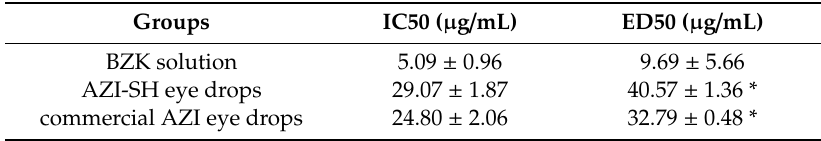
Figure 5. Cell viability against 3T3-L1 cells determined by MTT assay ( A ) and Neutral red uptake (NRU) assay ( B ). (** P < 0.01). Table 4. IC50 and ED50 values of BZK solution, AZI-SH eye drops and commercial AZI eye drops in MTT assay and NRU assay.